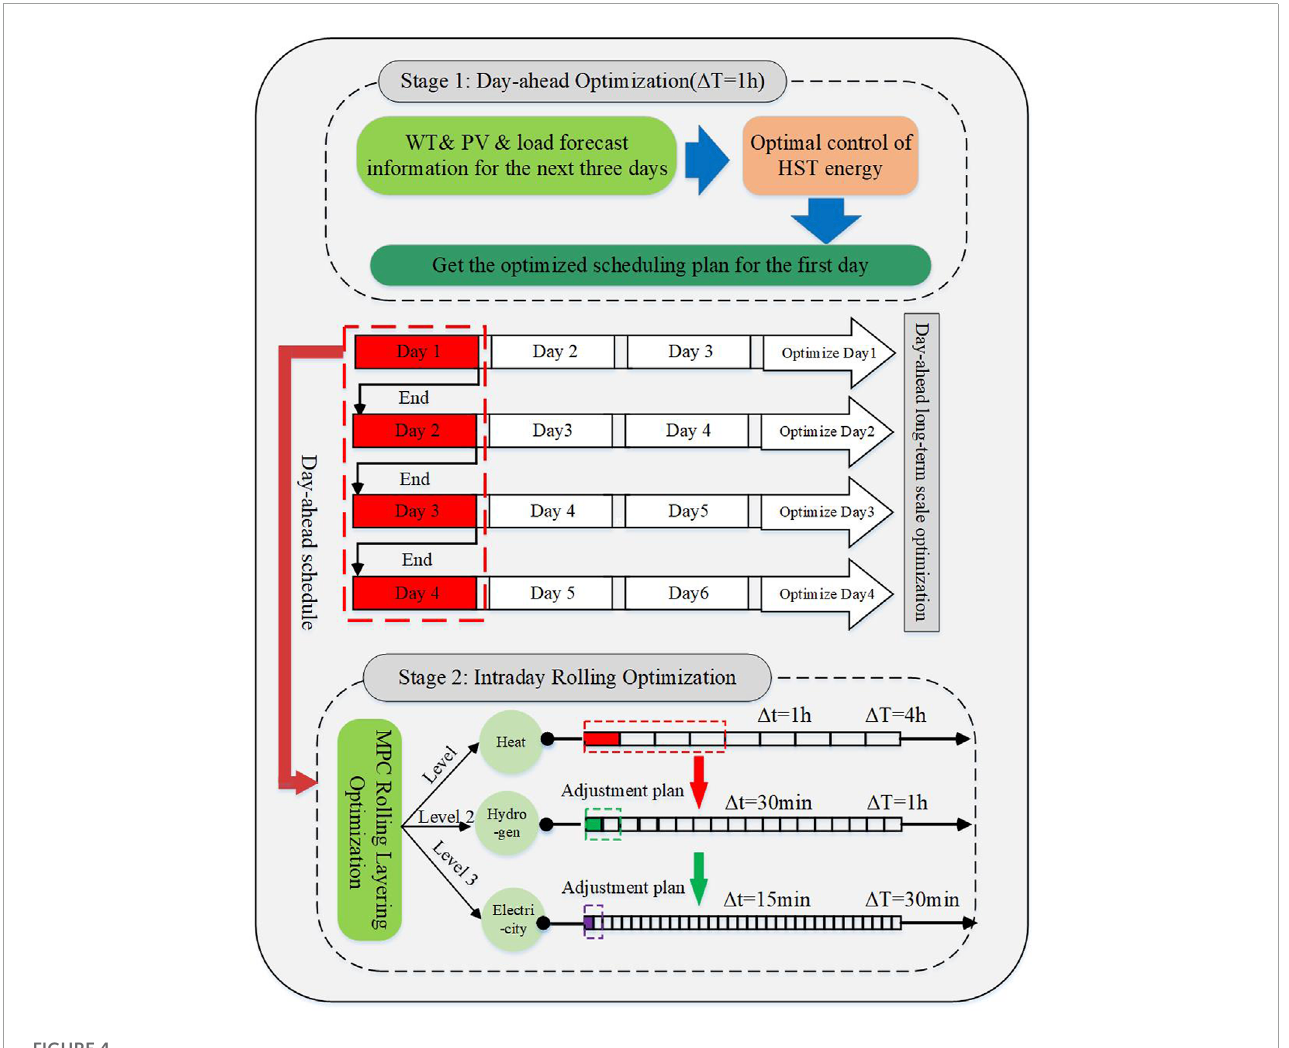
FIGURE 4 The proposed